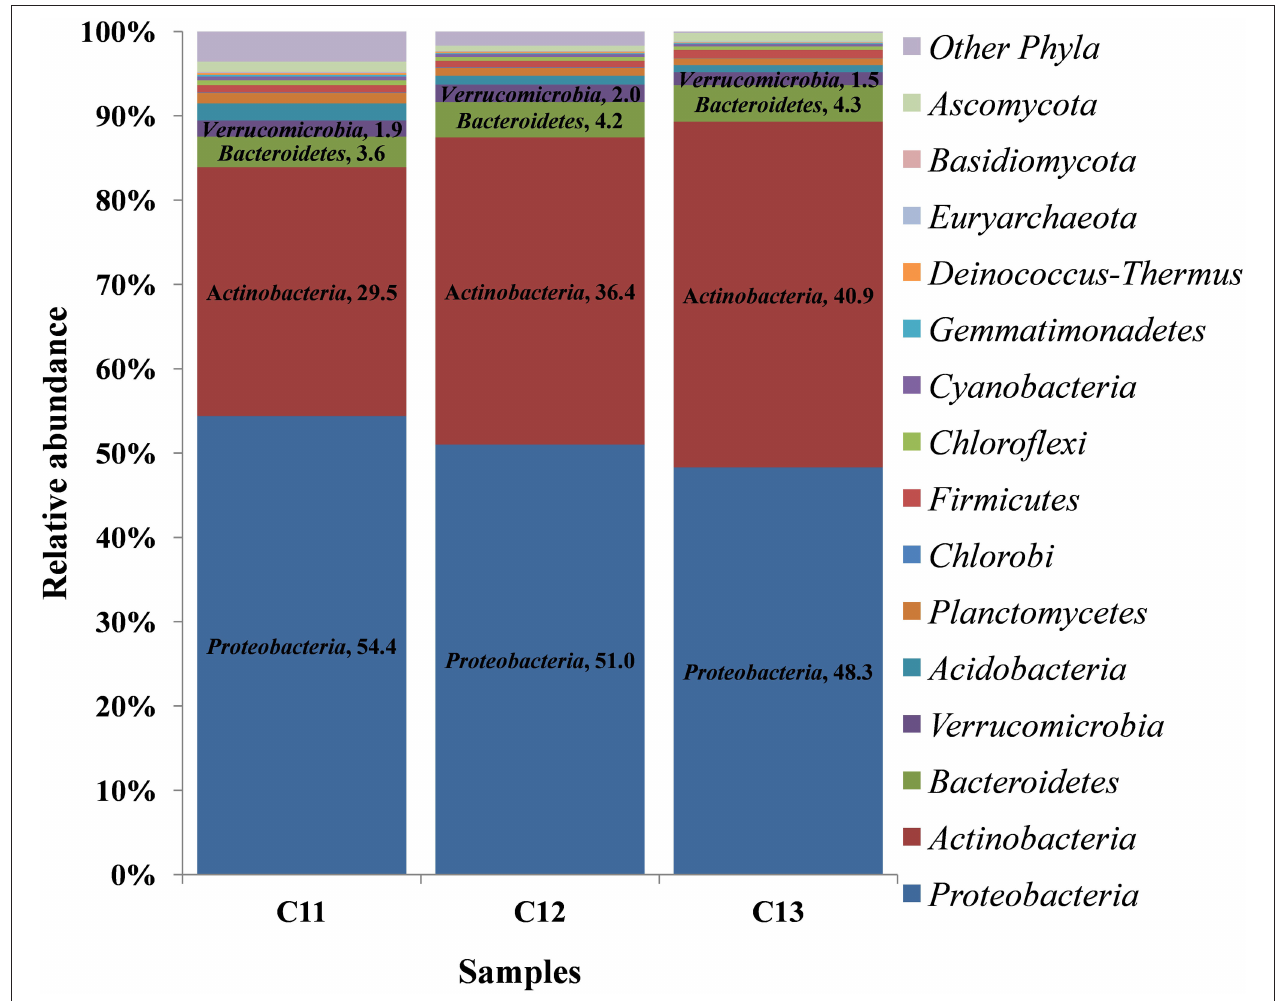
FIGURE 2 | Relative abundance of different phyla in the three consecutive years of Kishtwar (2011, 2012, and 2013). The bar graph depicts 15 phyla (12 bacterial, 2 fungal, 1 archaeal) cataloged from the cormosphere of saffron grown in